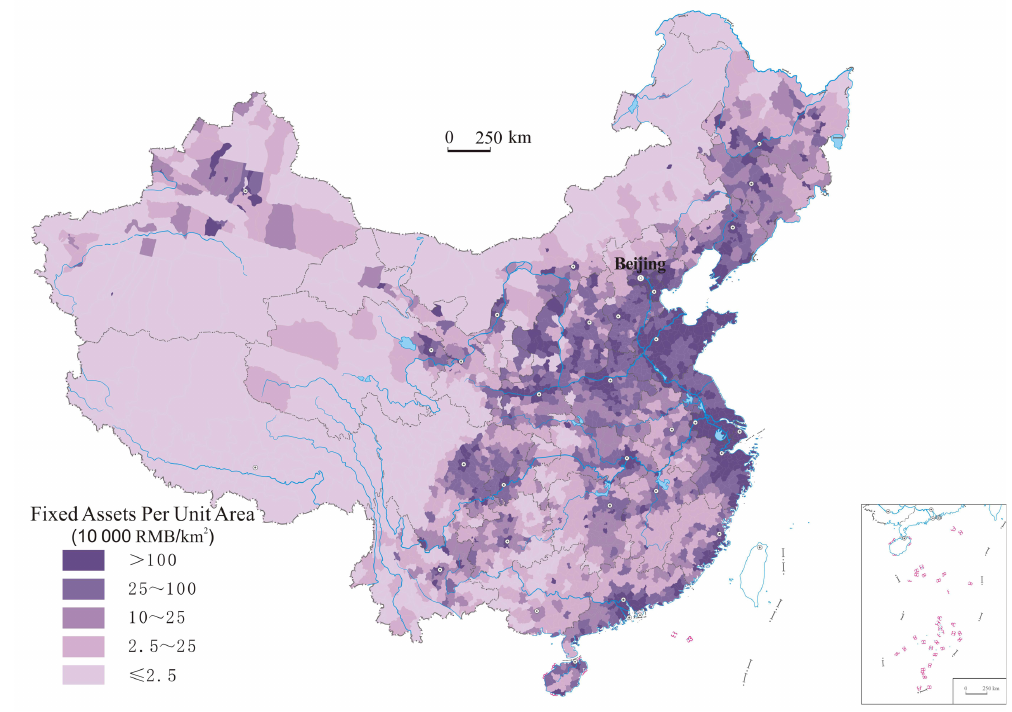
Fig. 3. Fixed assets per unit area of petrochemical